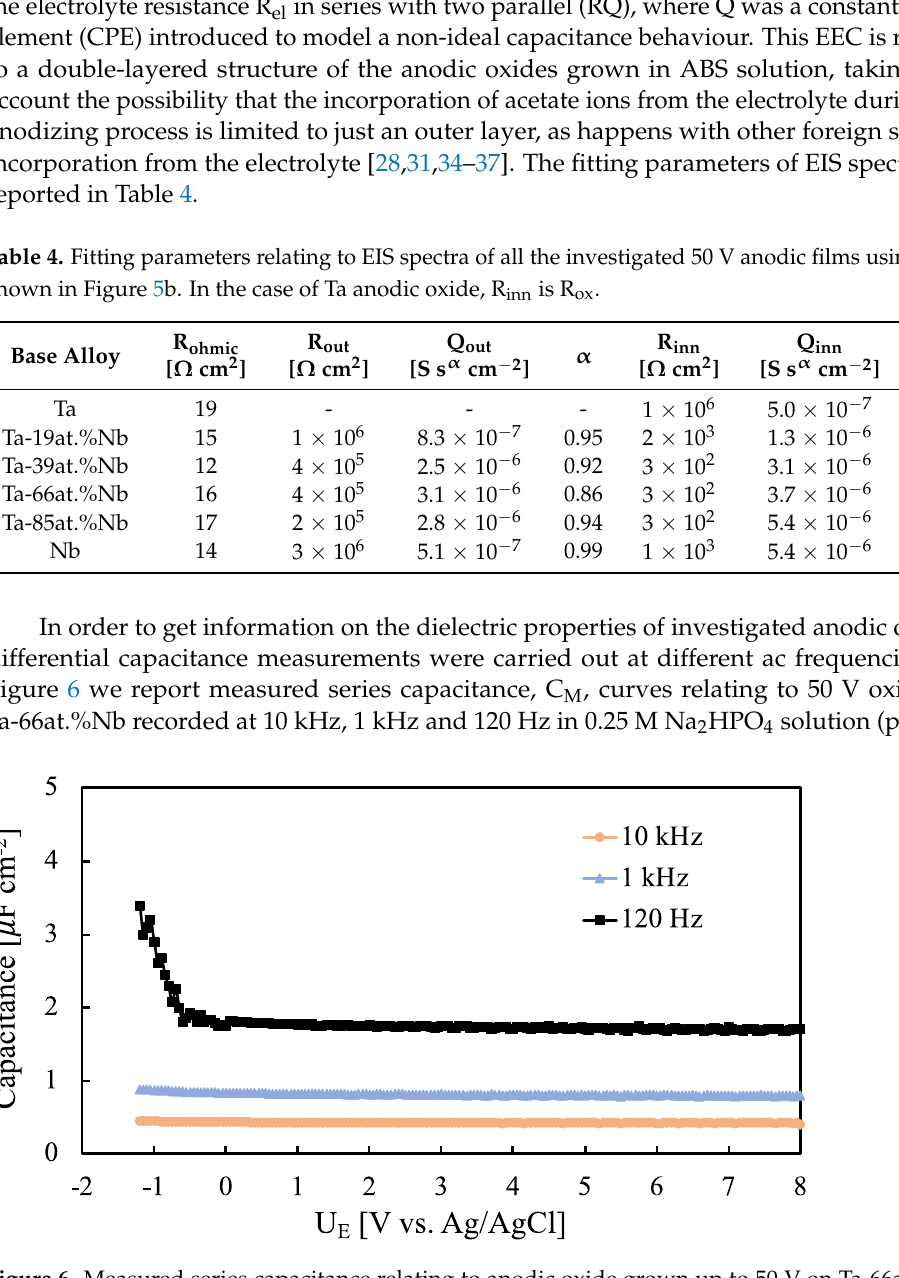
Figure 6. Measured series capacitance relating to anodic oxide grown up to 50 V on Ta-66at.%Nb recorded at 10 kHz, 1 kHz and 120 Hz in 0.25 M Na 2 HPO 4 solution (pH~9). It is noteworthy to mention that C M depends on the ac frequency, as typical of amor- phous materials. The dependence of C M on the electrode potential is almost negligible as typical for insulating materials unless the anodic oxide is tested under a strong cathodic polarization. C M measured at 120 Hz for all the investigated anodic oxides is shown in Figure 7.